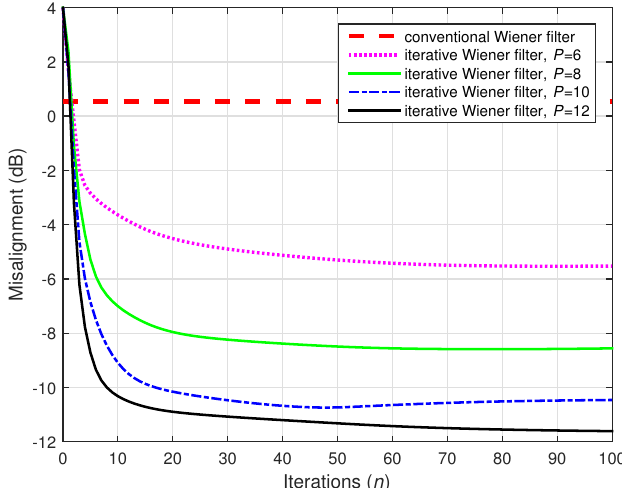
Figure 20. Performances of the conventional and iterative Wiener filters, using N = 2500. The source signal (white Gaussian noise) was preprocessed with positive and negative half-wave rectifiers, using α = 0.5. The numbers of channels were M = 2 (stereophonic scenario), L = 1024, and SNR = 30